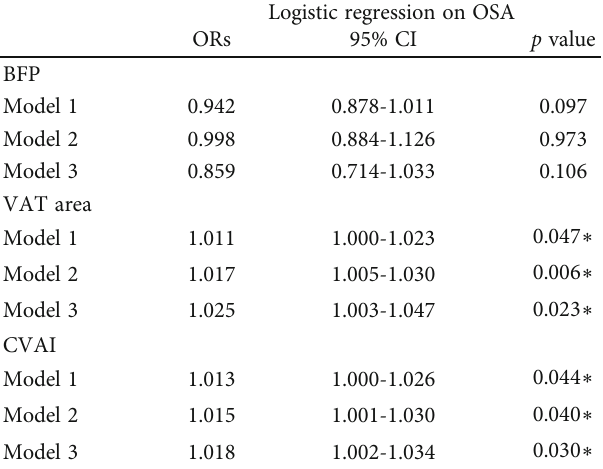
Table 2: Associations of VAT area, CVAI, and body fat percentage with OSA in patients with